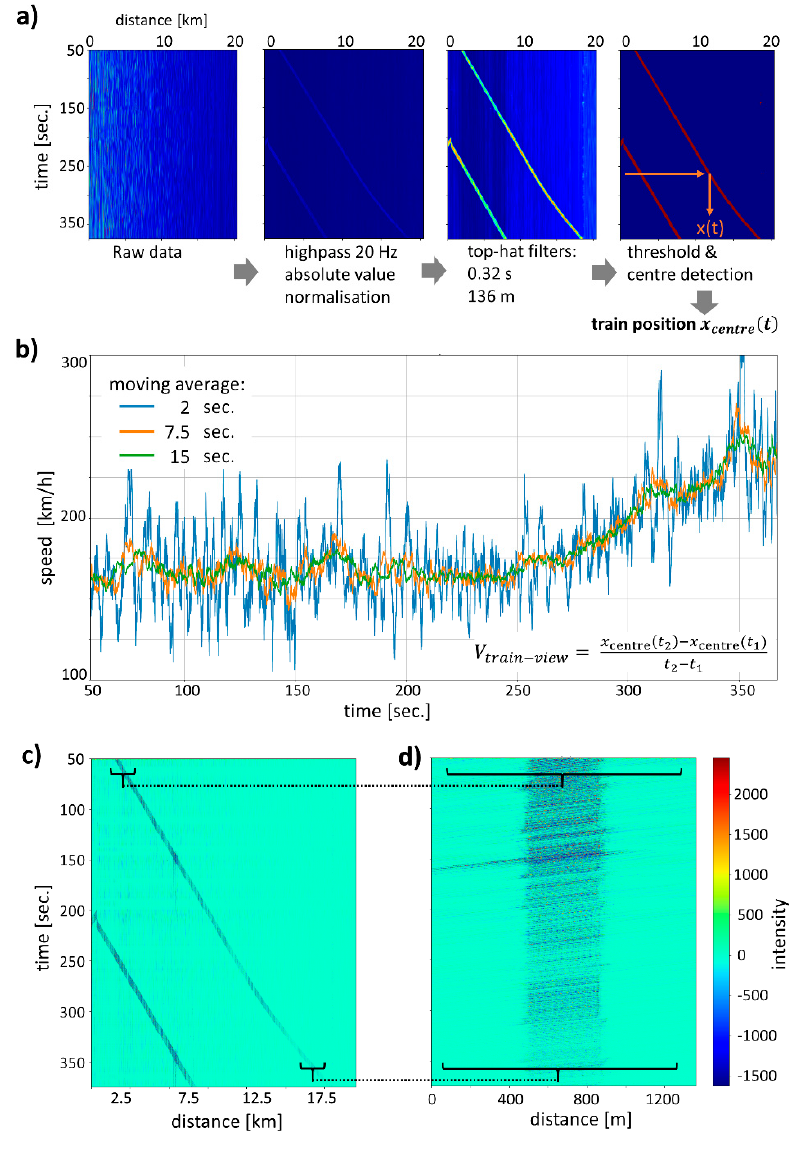
Figure 2. ( a ) The train position x center (t) as a function of time is determined by applying the shown filtering. ( b ) From this position, the train velocity of the ICE 4 train can be calculated at each given moment in time. ( c ) Using the previously determined position of the train, a section of DAS data with the train in the center can be cut and arranged to arrive at the ‘train-view’ representation of the data in ( d ).